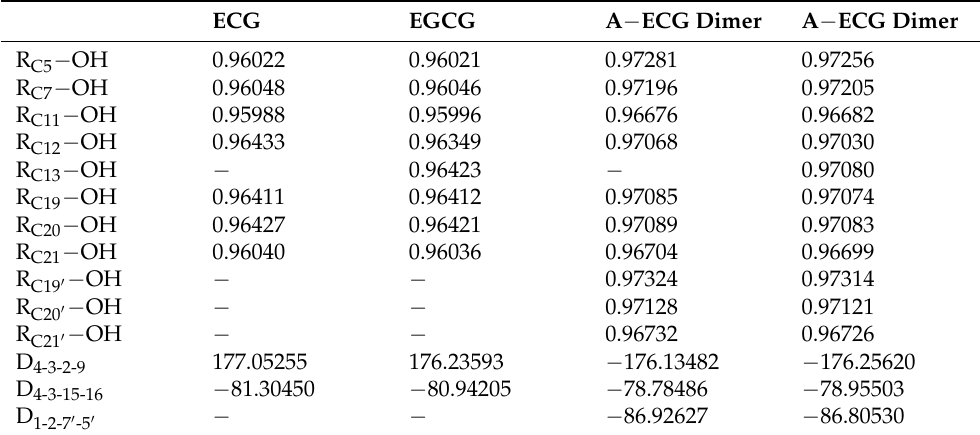
Table 1. The main structural parameters of the four PT characteristic structural